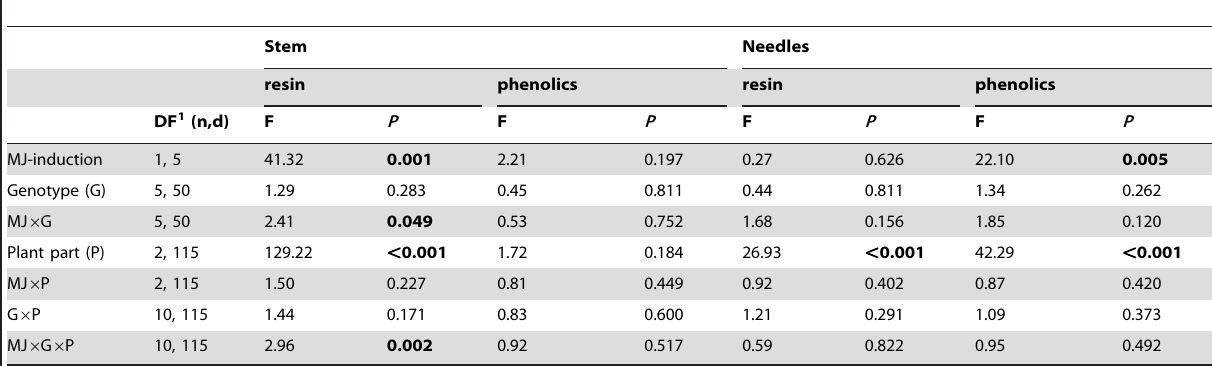
Table 1. Allocation of constitutive and induced chemical defenses across different pine parts.